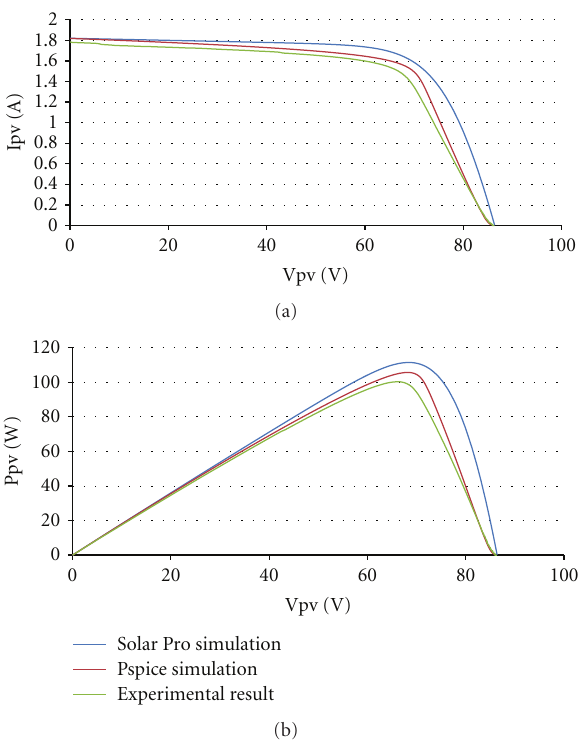
Figure 9: Comparison result for a 2 in series/2 in parallel module, (a) I - V , (b) P - V output characteristic